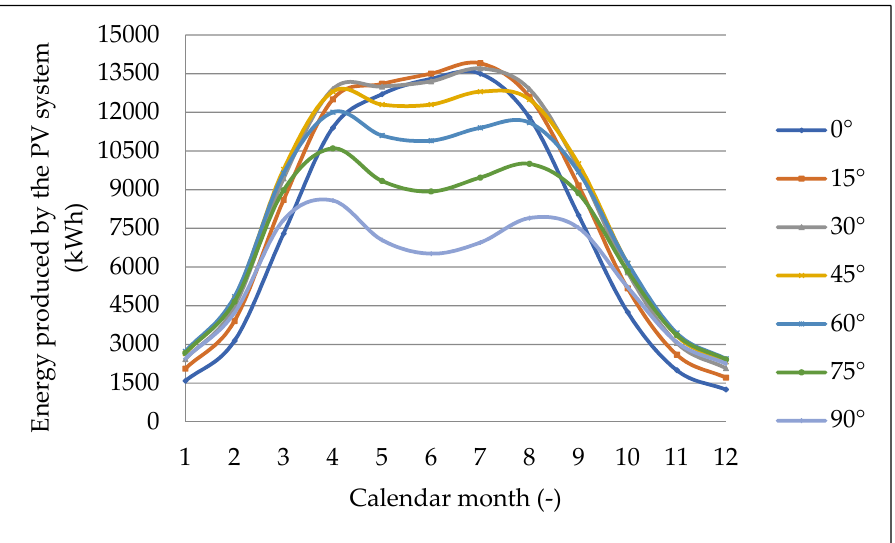
Figure 6. Dependencies of energy produced by the PV system for tilt angle range from 0° to 90°.